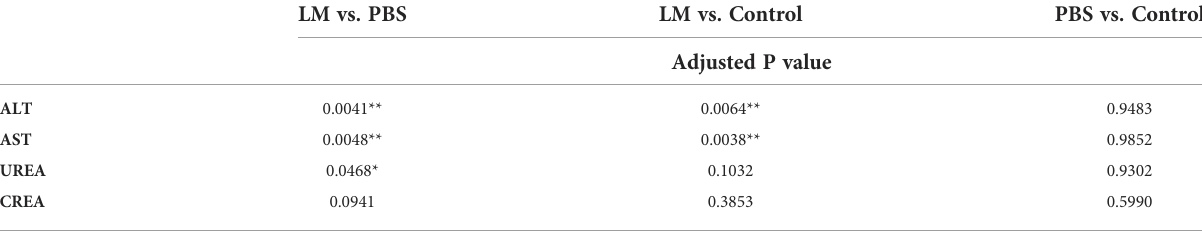
TABLE 4 The statistical results of post-hoc analysis in serum biochemical tests.